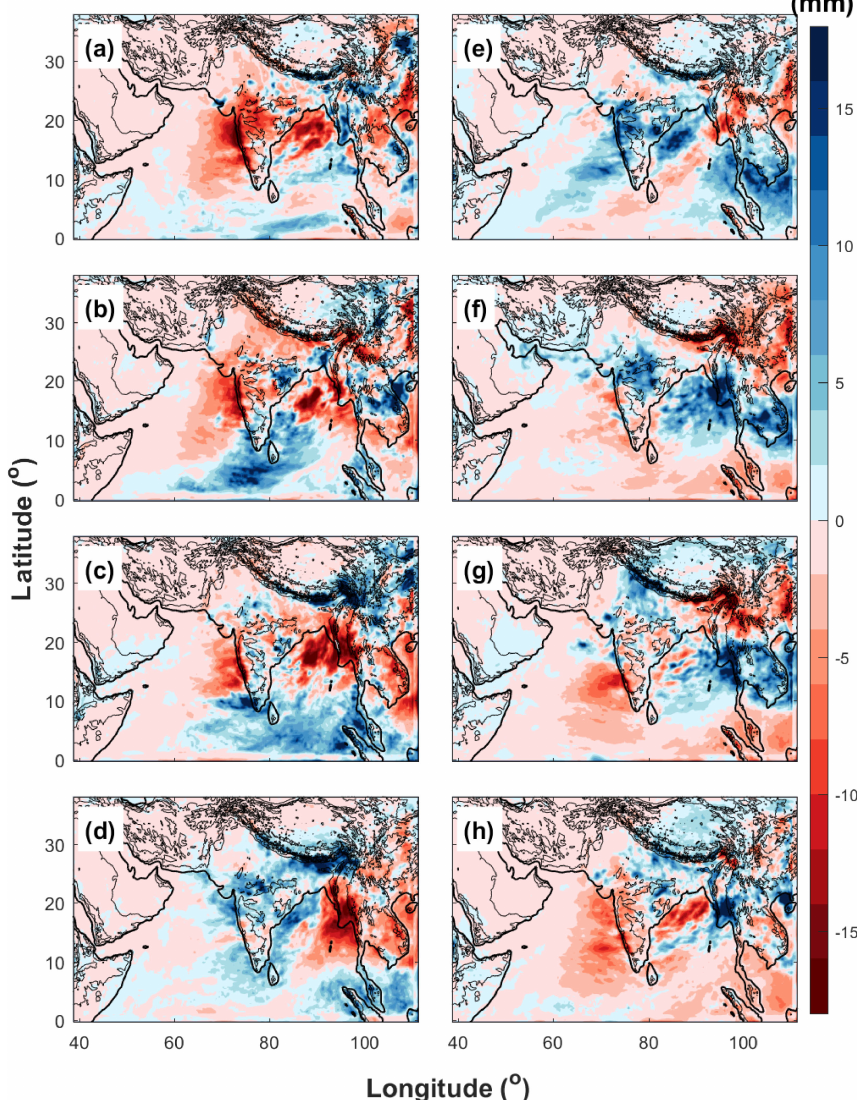
Figure 12. Phase composites of daily surface rainfall anomalies obtained from WRF-27km ( a–h : Phase 1 to